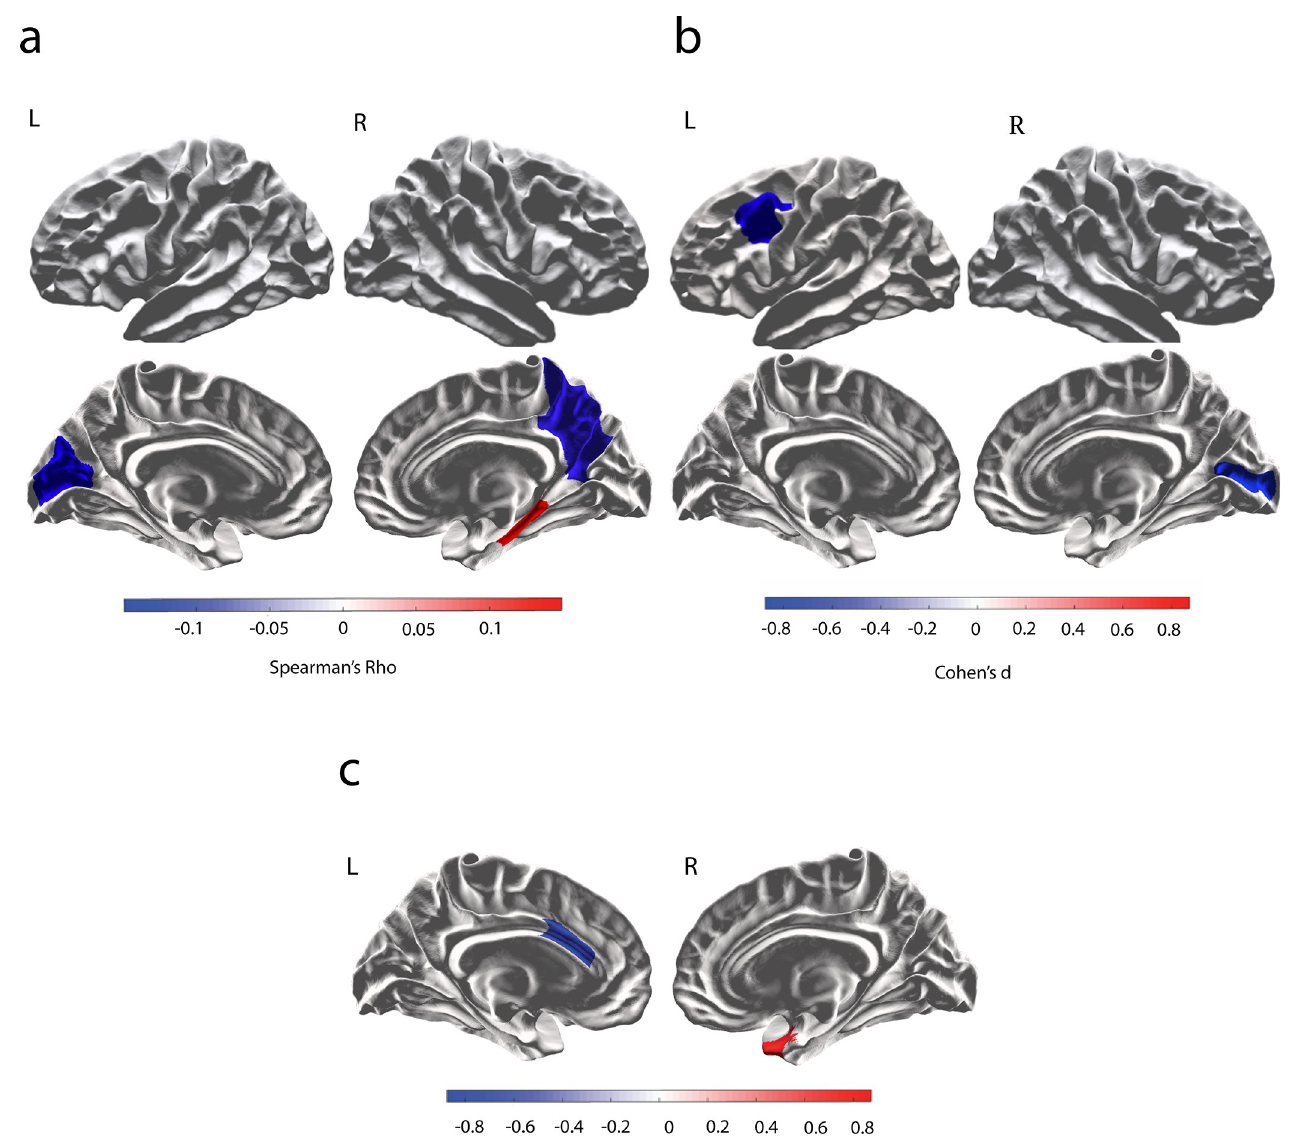
Fig 1. (a) Spearman’s Rho for brain regions showing a significant relationship between cortical thickness and number of children for female. Regions highlighted in red (right parahippocampal gyrus) depict a positive relationship, regions highlighted in blue (left pericalcarine sulcus and cuneus) depict a negative relationship. (b) Cohen’s d for the difference between females with one child and females with zero children. Regions highlighted in blue (left caudal middle frontal/DLPFC, right pericalcarine sulcus) depict a negative Cohen’s d and thinner GM in mothers, compared with non-mothers. (c) Cohen’s d for the difference between males with one child, to males with zero children. Regions highlighted in red (right temporal pole) depict a positive Cohen’s d and thicker GM in fathers, regions highlighted in blue (left caudal anterior cingulate cortex) depict a negative Cohen’s d and thinner GM in fathers compared with